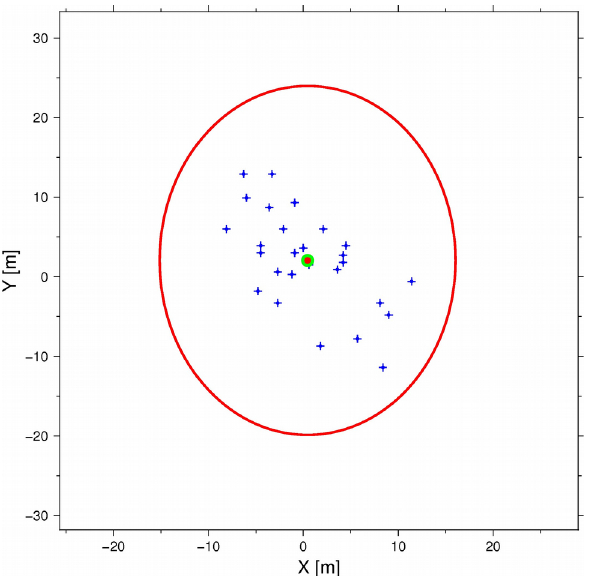
Figure 5: The individual 2D displacement of each LOLA track required in order to match with the NAC DTM (blue plus signs). The final position of the adjusted NAC DTM (green dot) lies in the geometric center (red dot) of all available LOLA tracks whose shift values lie within the 3σ range (red ellipse). The remaining